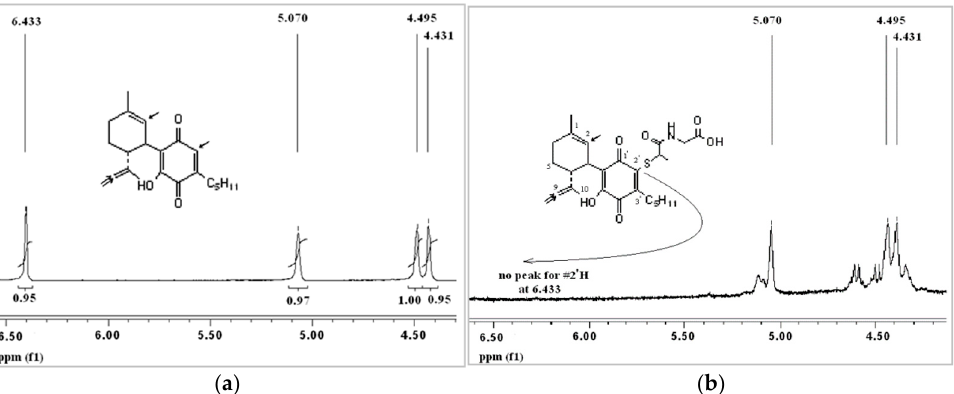
Figure 4. 1 H-NMR analysis of MPG binding to HU-331: ( a ) expansion of region 4–6.5 ppm of HU-331 H1-NMR; ( b ) expansion of region 4–6.5 ppm of HU-331 1 H-NMR after the addition of MPG.